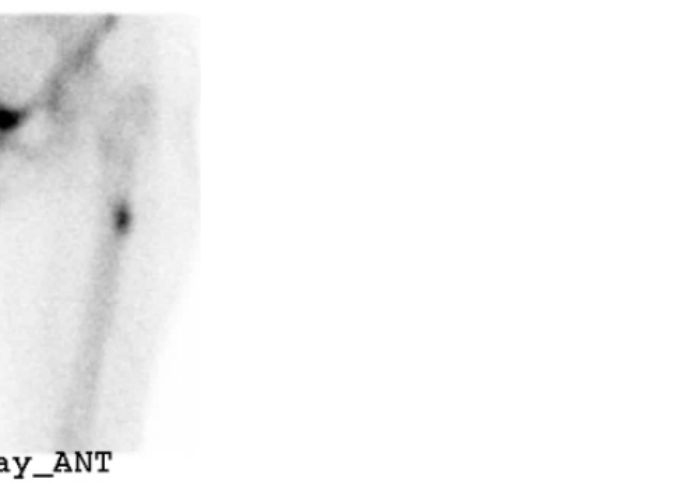
Figure 2. Bone scan (three phases) displayed focal increased uptakes in both proximal femur lateral bony cortex.